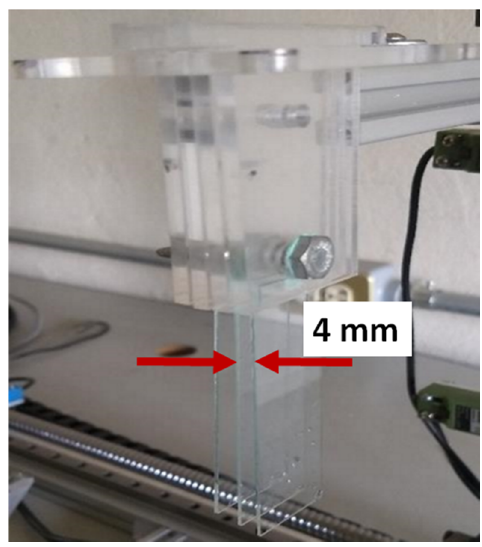
Figure 15. Substrate